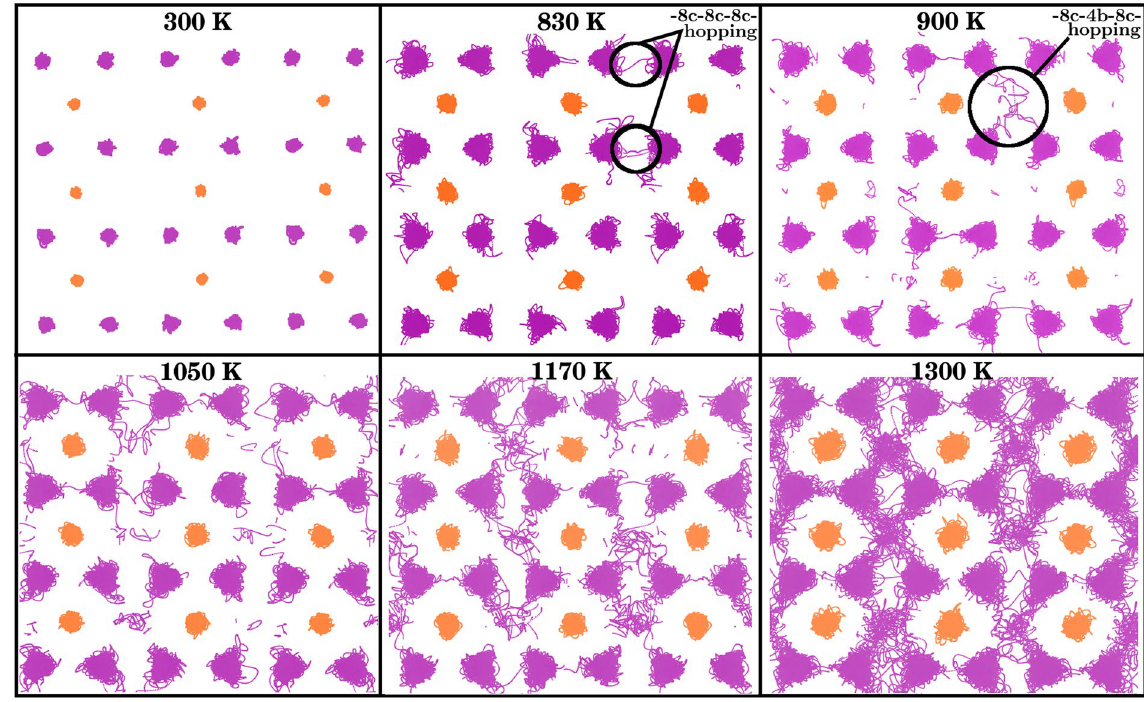
Figure 2. Visited Li and S ion positions in the { 110 } planes of Li 2 S within slices of 1.7 Å thickness during 40 ps of AIMD simulations at 300 K, 830 K, 900 K, 1050 K, 1170 K and 1300 K. The visited positions by Li and S ions are in purple and gold,